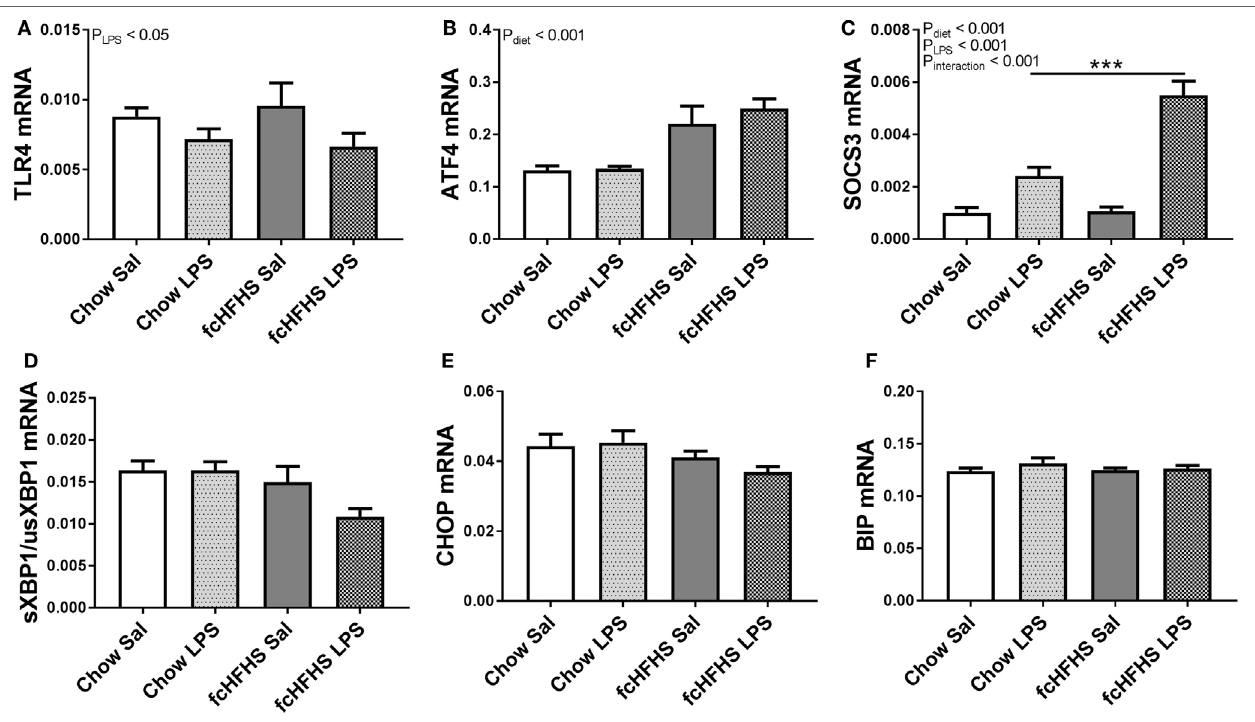
FigUre 2 | Lipopolysaccharide (LPS) decreased (a) relative toll-like receptor 4 ( Tlr4 ) mRNA expression, whereas 1 week of free-choice high-fat high-sugar (fcHFHS) diet increased (b) relative activating transcription factor 4 ( Atf4 ) mRNA expression in the hypothalamus of rats. An interaction effect between diet and LPS was observed in (c) relative suppressor of cytokine signaling (Socs) 3 mRNA levels. Relative expression of endoplasmic reticulum stress markers (D) sXBP1 / usXBP1 , (e) C/EBP homologous protein (CHOP) or (F) immunoglobulin-heavy-chain-binding protein (BIP) were not affected. Statistical analysis was performed using two-way ANOVA followed by post hoc analysis in case of an interaction effect. Specific gene expression was normalized to the geometric mean of three housekeeping genes ( Hprt * Actb * Ppia ) 1/3 . Data are presented as mean ( n = 8) ± SEM; *** p <